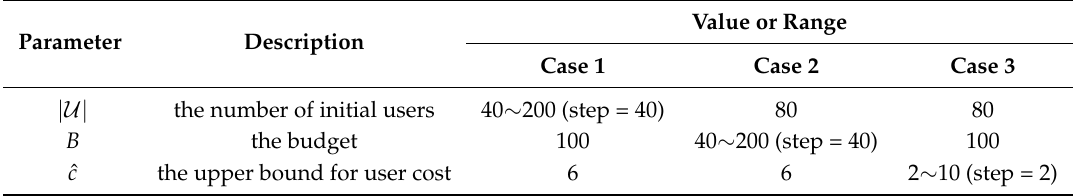
Table 1. Setup of parameters and variable ranges used in each